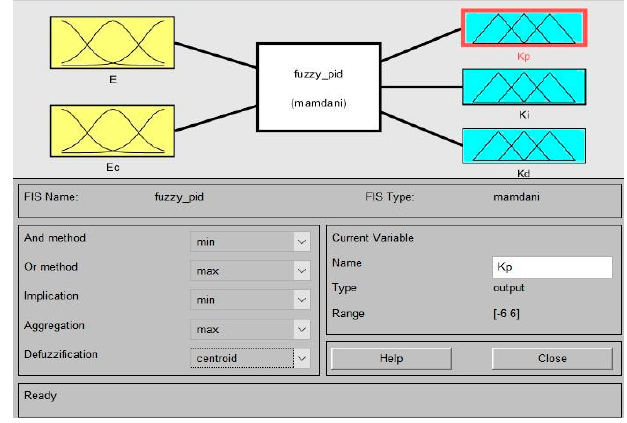
Figure 5. Fuzzy logic toolbox.